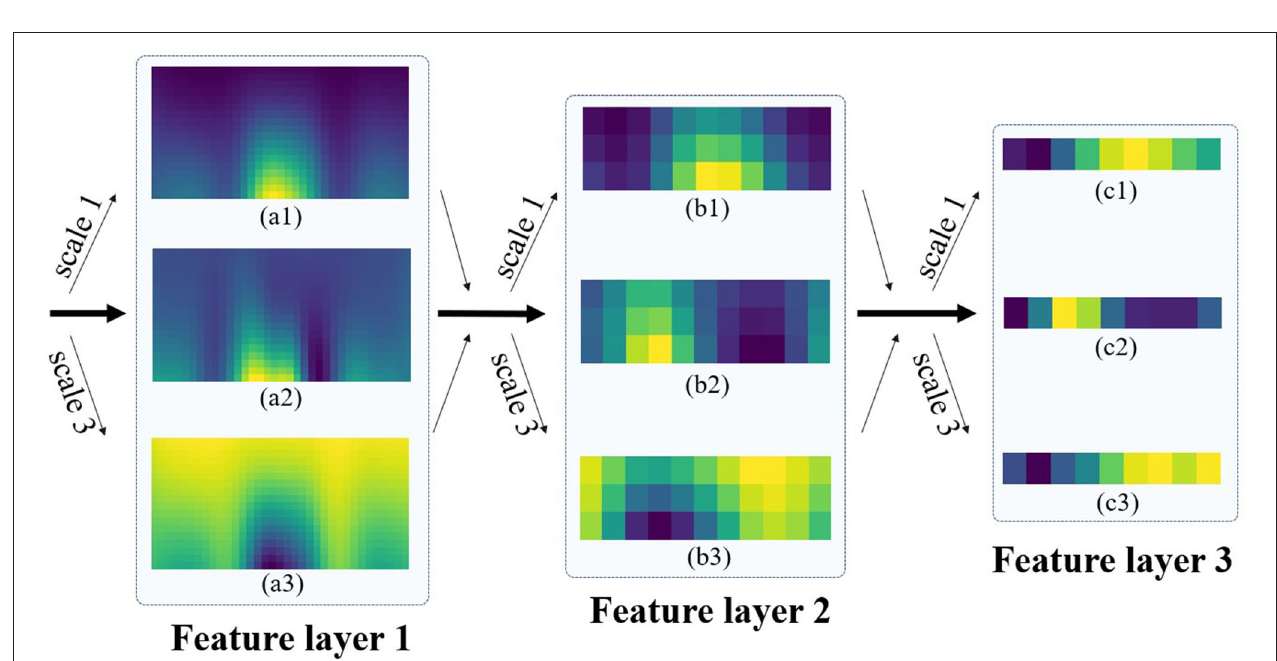
FIGURE 10 | Visualization of intermediate feature layer of multi-scale convolution